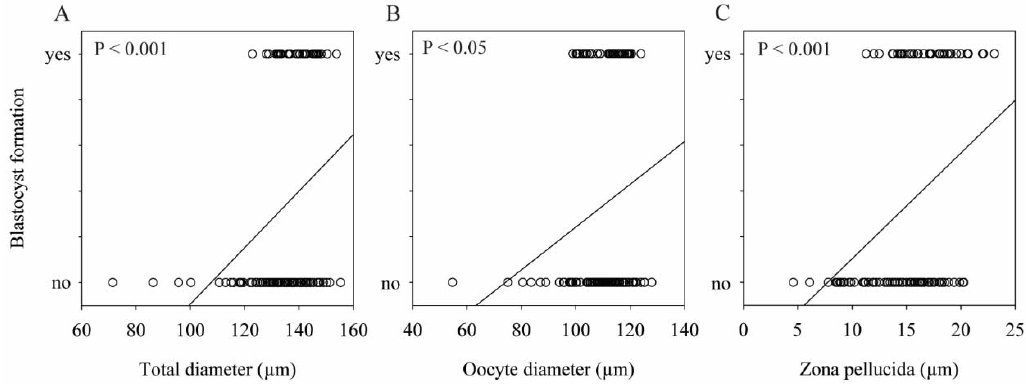
Figure 1. Relationship between blastocyst formation and morphometric measures: ( A ) total diameter, ( B ) oocyte diameter, and ( C ) zona pellucida thickness. Each circle on the graph represents an oocyte that was evaluated. The oocytes analyzed were defined by binary values (0 = no; 1 = yes). A logistic regression is represented by the following equations: Logit P = –13,462 + (0.0935 × total diameter), p < 0.001; Logit P = –6562 + (0.0530 × oocyte diameter), p < 0.05; Logit P = –4577 + (0.252 × total diameter), p < 0.001.